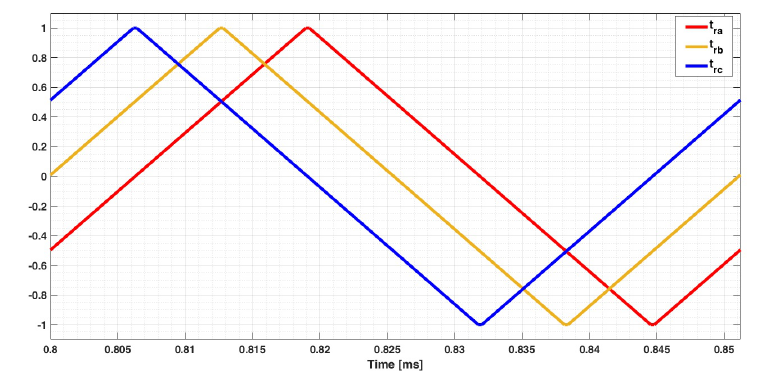
Figure 7. Carriers t ra , t rb , t rc related to an angle of α u = 45